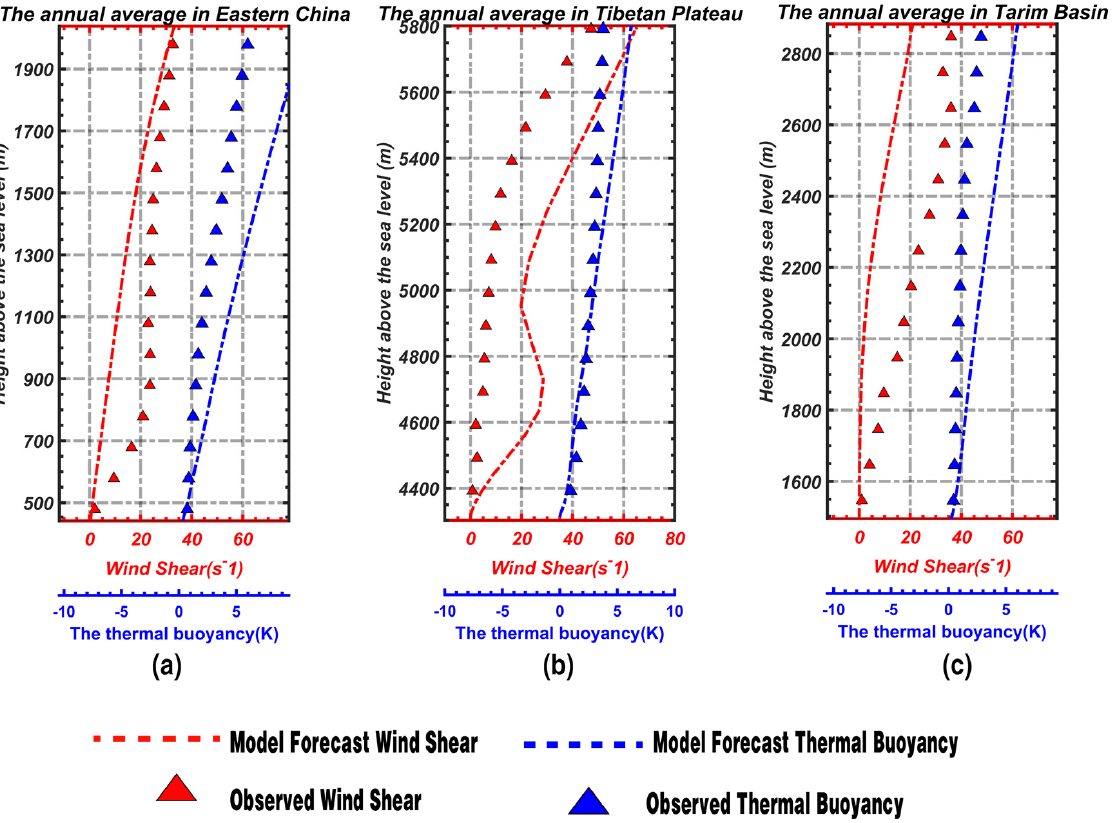
Figure 9. Observed (triangle) and CMA-GFS model (dotted line) annual average wind shear (red) and thermal buoyancy (blue) in ( a ) East China, ( b ) the Qinghai–Tibetan Plateau, and ( c ) the Tarim Basin.